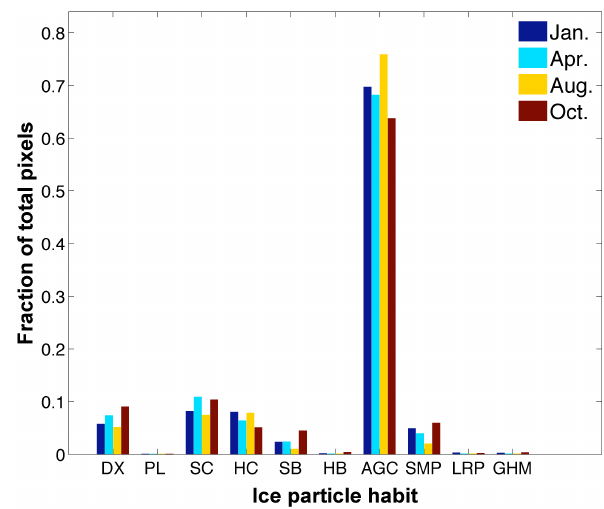
Fig. 1. Global inferred ice habit from four different months, shown as a histogram of the fraction of total pixels assigned as one of the 9 single habits or habit mixture. Results are for ice cloud pixels over ocean. DX = droxtal, PL = plate, SC = solid column, HC = hollow column, SB = solid bullet rosette, HB = hollow bullet rosette, AGC = compact aggregate of columns, SMP = 5 member spatial aggregate of plates, LRP = 10-member spatial aggregate of plates, and GHM = general habit